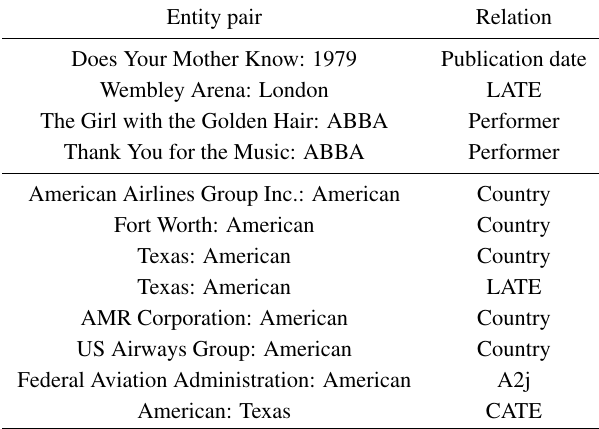
Table 5 Examples of the incremental output from our model.